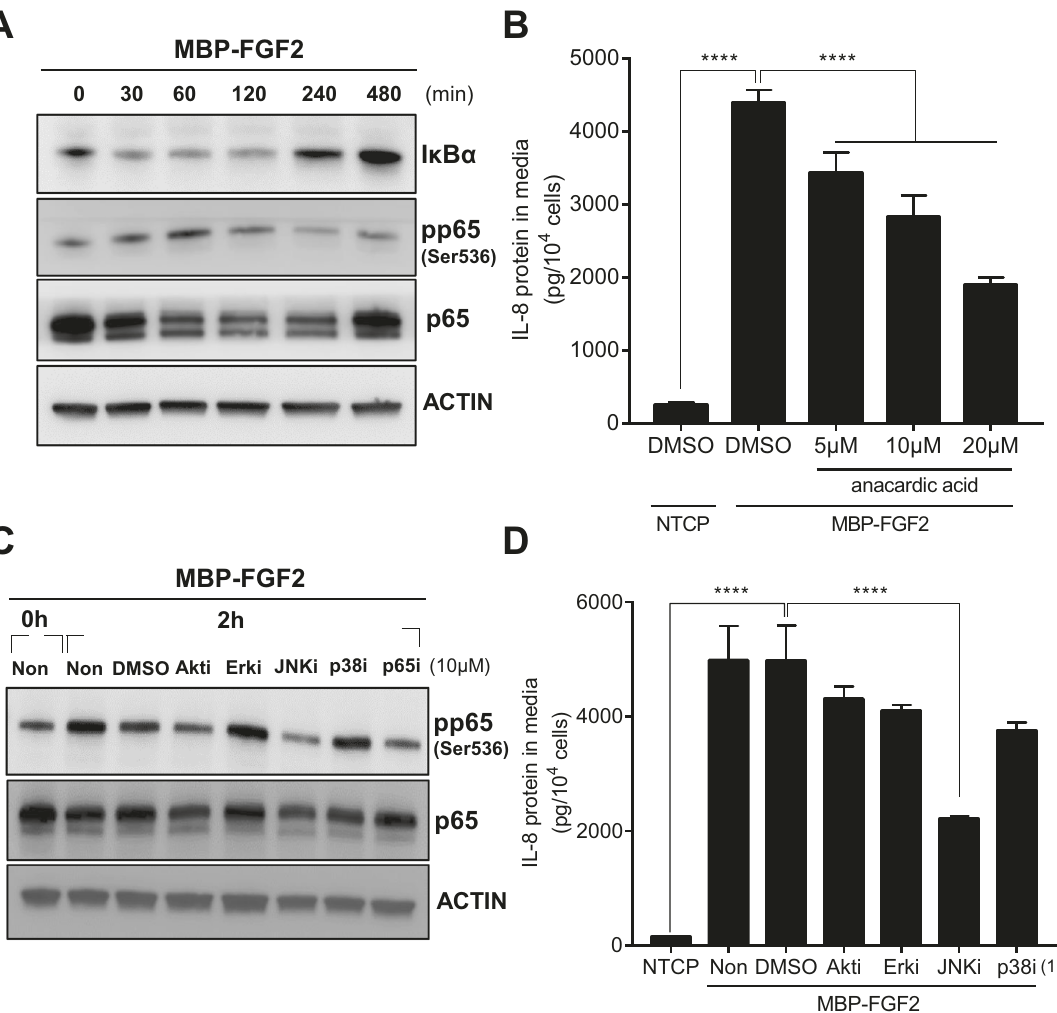
Fig. 4 Regulation of IL-8 expression of MBP-FGF2 through JNK-NF- κ B cascade. hASCs were cultured on MBP-FGF2 surface in the presence of various inhibitors for downstream molecules. Total proteins and conditioned medium were prepared and analyzed by western blot and ELISA, respectively. A Time-dependent activation of NF- κ B signaling pathway of hASC on the MBP-FGF2 surface. B Effect of anacardic acid on IL-8 protein expression. **** p < 0.0001 (one-way ANOVA), n = 4 per group. C Effect of various chemical inhibitors on the MBP-FGF2-mediated increase of phosphorylated p65. D Effect of chemical inhibitors on the MBP-FGF2-mediated regulation of IL-8 expression. **** p < 0.0001 (one- way ANOVA), n = 4 per group. For western blot analysis, β -actin was used as a loading control. All data are presented as mean ±